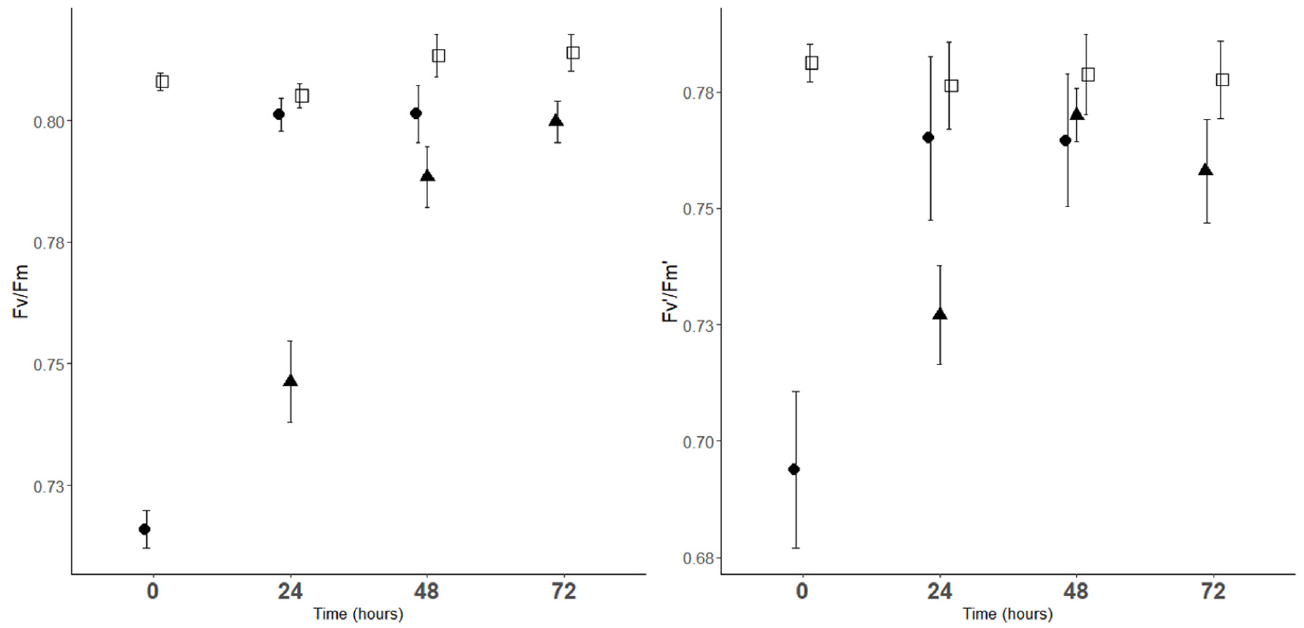
Figure 1. The maximum quantum efficiency of PS II (Fv/Fm) and the effective quantum efficiency of PS II (Fv’/Fm’) of sweet cherry leaf, at time 0, time 24, time 48 and time 72. ● , CT1 (one cold night exposure); ▲ , CT2 (two cold night exposures) and □ , C (control trees). Vertical bars represent ± SE of the mean ( n = 6 or 9).